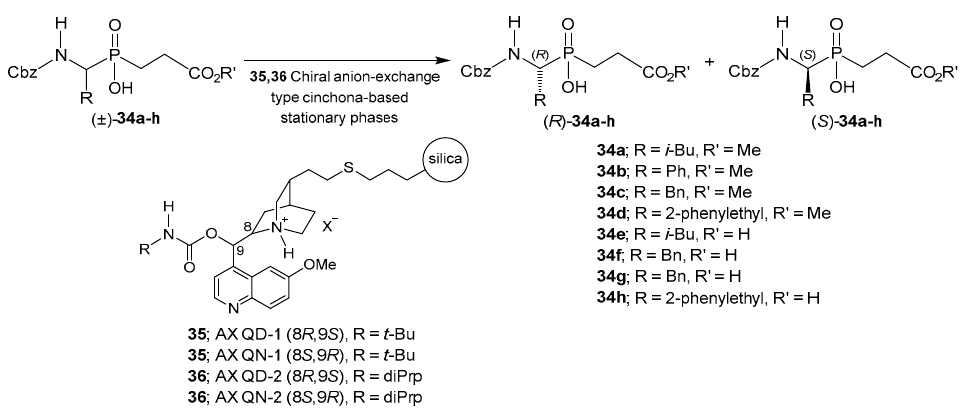
Scheme 21. Chiral HPLC separation of N -Cbz phosphinic pseudopeptides 34a – h